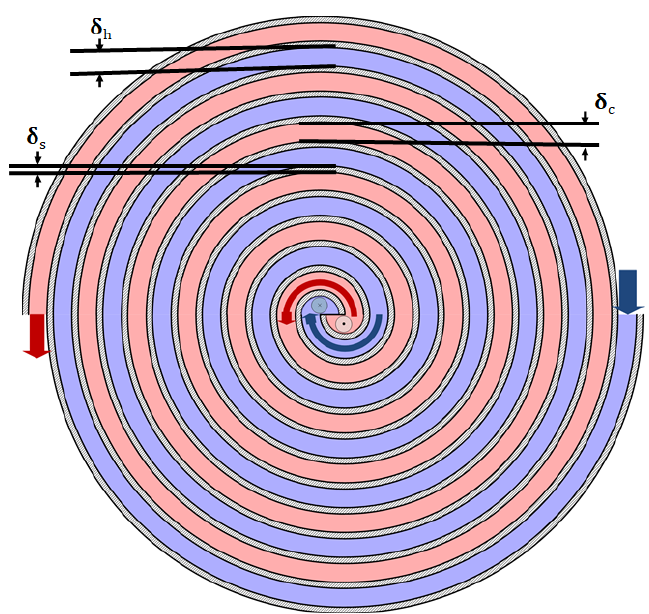
Figure 2. The cross-section inner structure of the spiral heat exchanger.